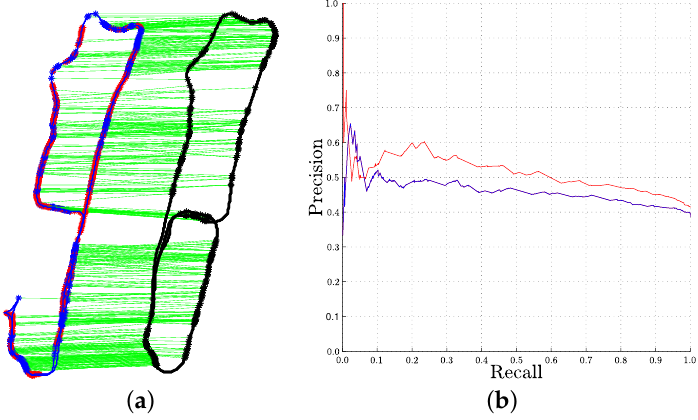
Figure 11. Our vocabulary vs. standard k -means vocabulary for Place Recognition. ( a ) odometry of the two sequences used: Test ( blue ) and Train ( black ). Correct localization results are shown as green lines, and errors are shown with red points in the test trajectory; ( b ) precision-recall curves using our enhanced vocabulary ( red ) and k -means vocabulary ( blue ). These curves have been obtained varying th HistDist . (Best seen in